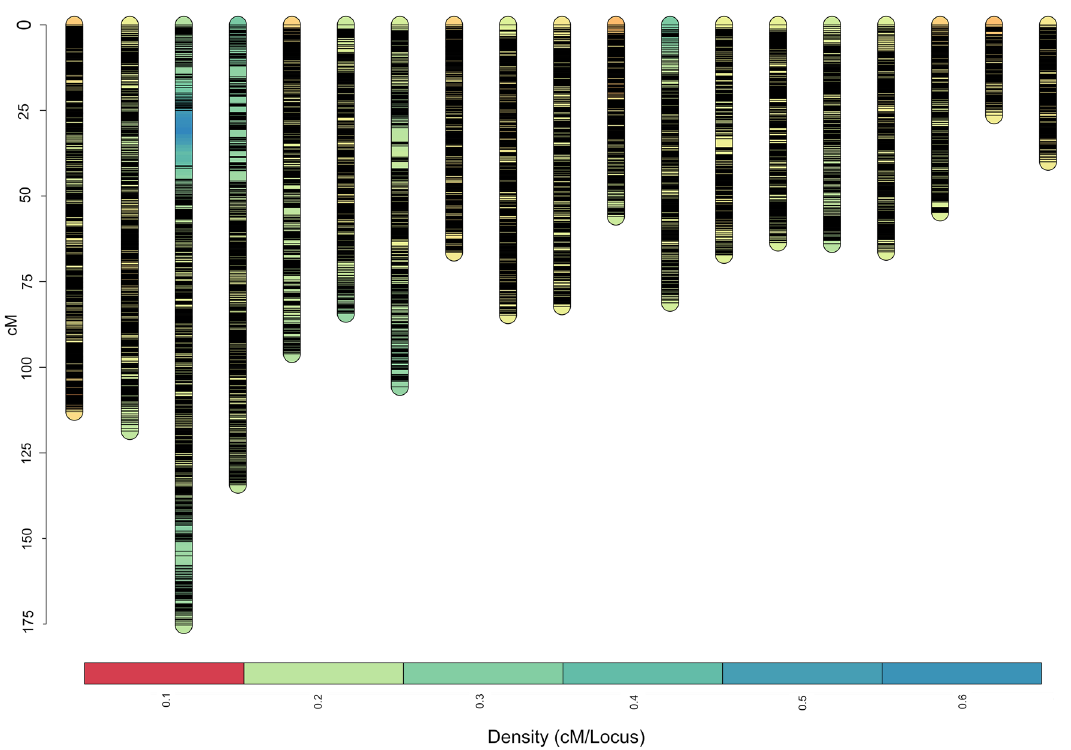
Figure 3. Graphical representation of the consensus map of C. edule including 13,874 markers encompassing 1073 cM.. The rule in the left indicates length in centimorgans